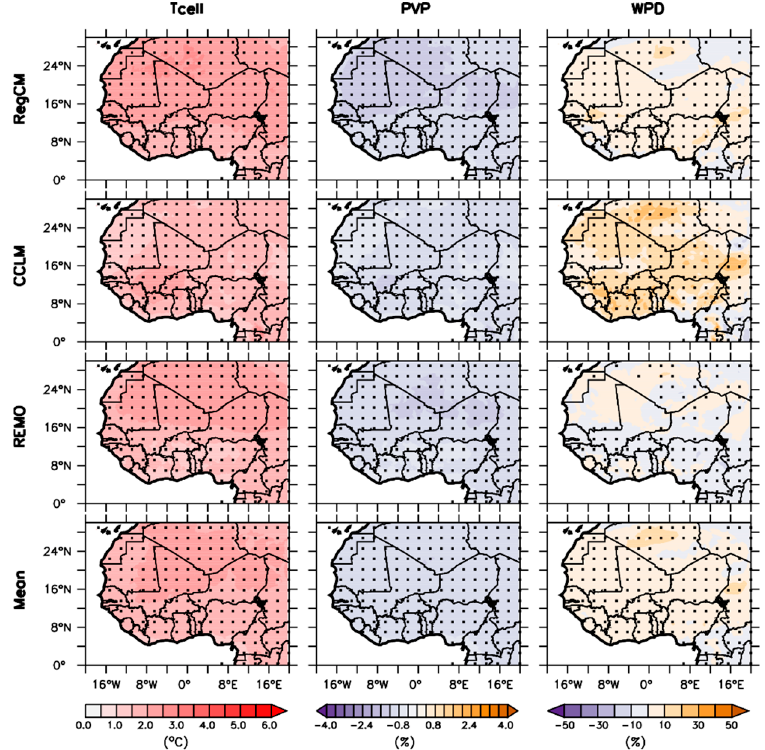
Figure 10. Projected changes in the annual average of the cell temperature (Tcell), photovoltaic potential (PVP), and wind power density (WPD) over West Africa for the near future (2021–2050) and under the RCP8.5 scenario. Statistically significant areas are indicated with black